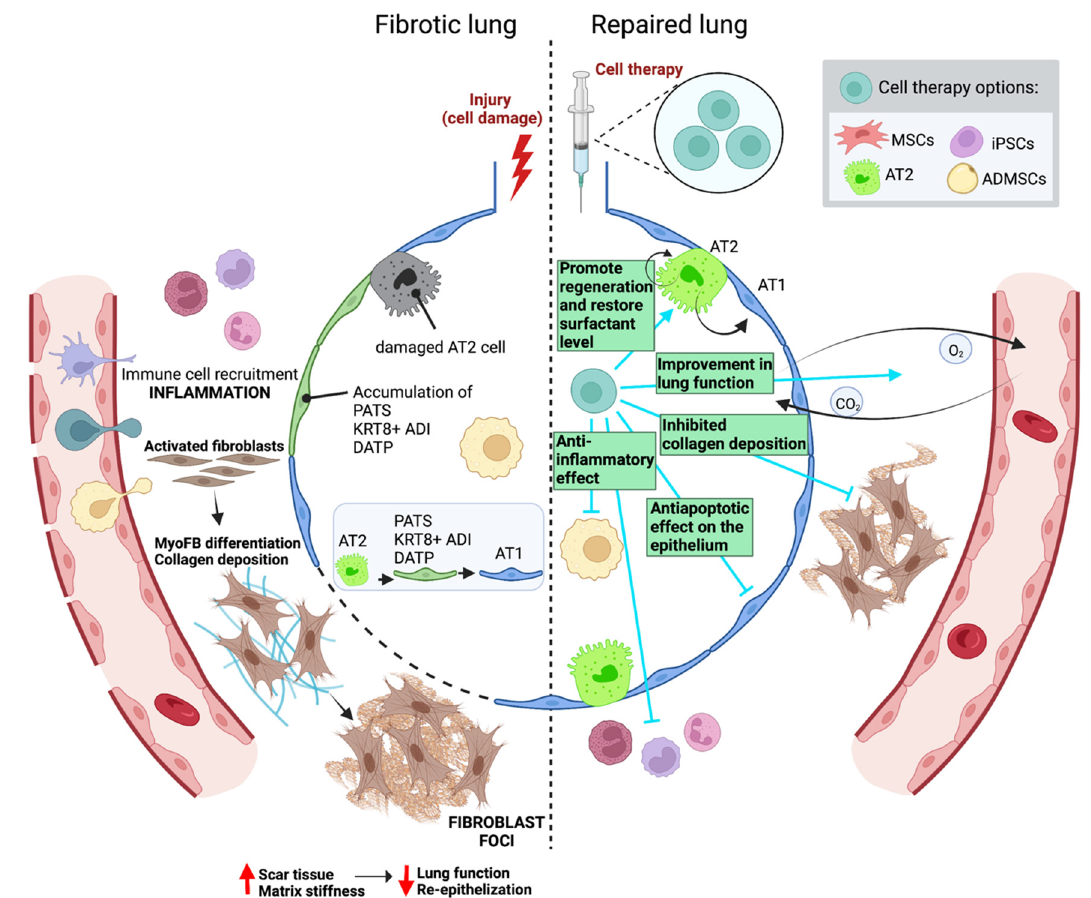
Figure 3. Stem cell-based therapies in lung fibrosis. Left: In the fibrotic lung the excess of collagen deposition evokes tissue scarring increasing matrix stiffness which impairs lung function. Re- epithelization is also affected due to alveolar type 2 (AT2) cells’ failure to completely differentiate into AT1 cells as they are stuck in an intermediate cell state known as damage-associated transient progenitors (DATPs), pre-alveolar type-1 transitional cell state (PATS) or keratin 8-positive alveolar differentiation intermediate (Krt8+ADI). Right: Adult mesenchymal stromal/stem cells (MSCs), induced pluripotent stem cells (iPSCs), AT2 cells and adipose mesenchymal stem cells (ADMSCs) have been proposed for cell transplantation to induce alveolar regeneration. Stem cell-based therapy has proven to exert beneficial effects by promoting epithelial regeneration, restoring surfactant levels, inhibiting collagen deposition, exerting an antiapoptotic effect on the epithelium and also showing anti-inflammatory effects; all of this contributes to improved lung function (Image created with